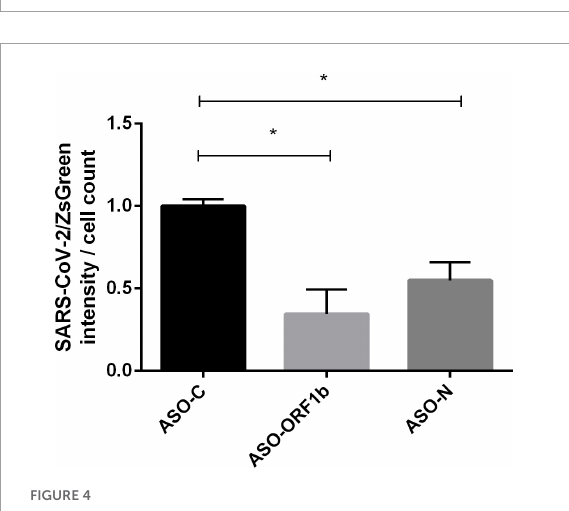
correctly splitting the two replicase proteins pp1a and